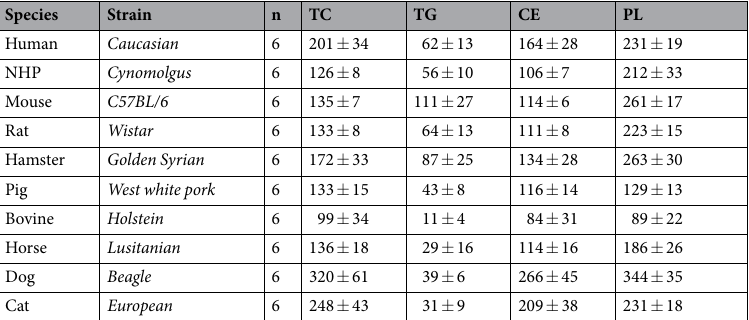
Table 1. Plasma lipid concentrations in human and animal plasma. Values are mean ± standard deviation (3 males, 3 females) and are expressed in mg/dL. TC, total cholesterol; TG, triglycerides; CL, cholesterol esters; PL,